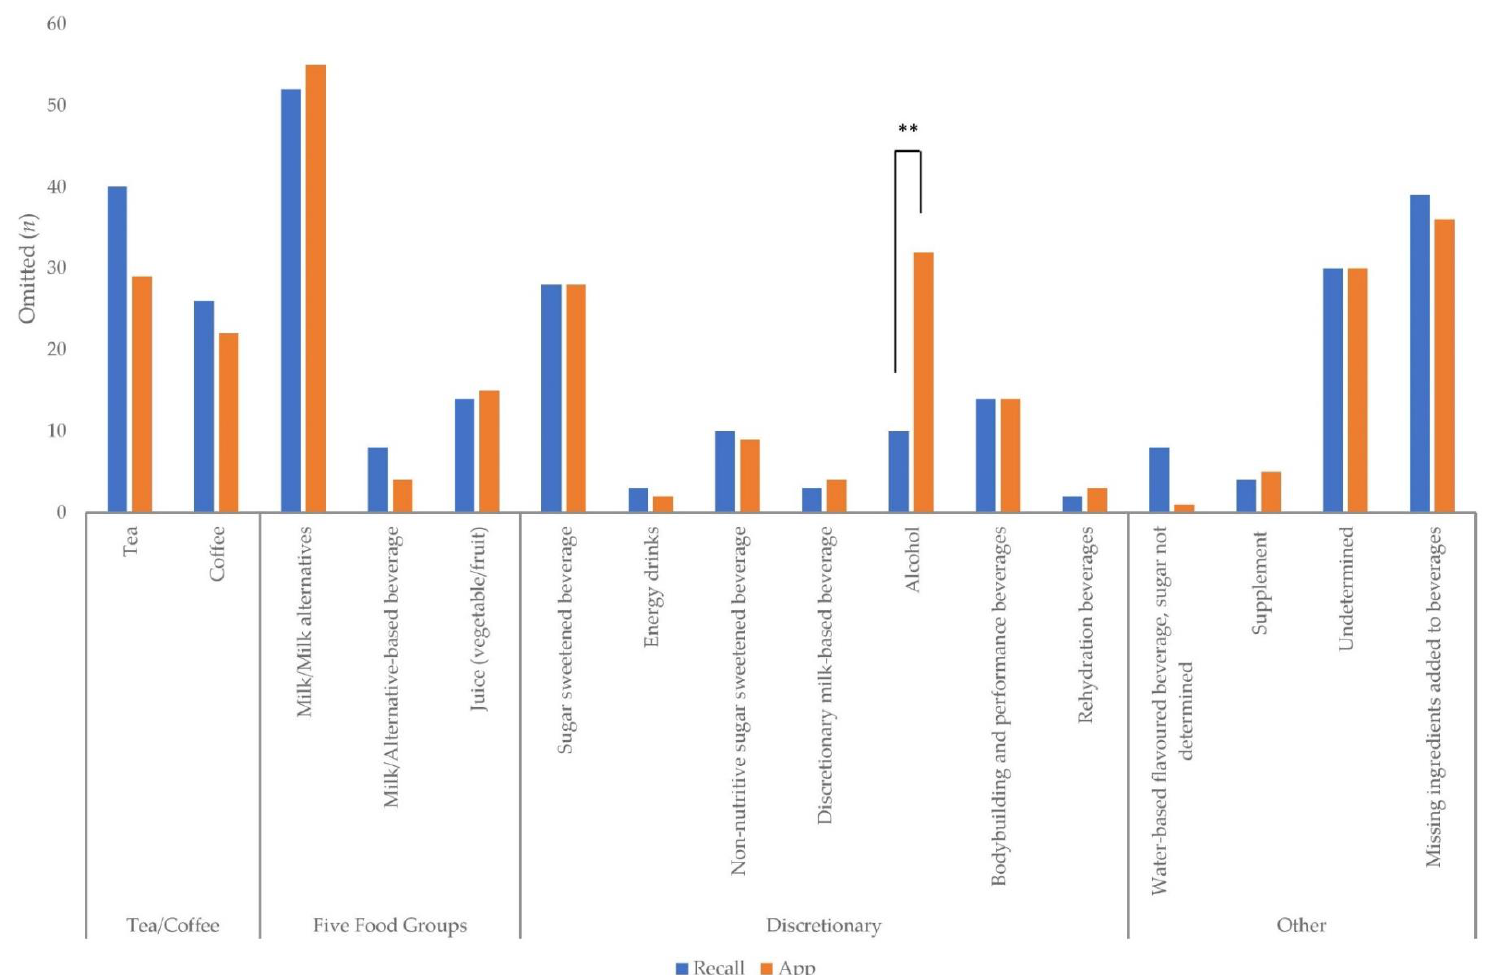
Figure 4. Frequency ( n ) of beverages or beverage components missing from dietitian-administered 24 h recall and app. Differences between 24 h recall and app that were statistically significant are indicated by bars: ** p = 0.002.